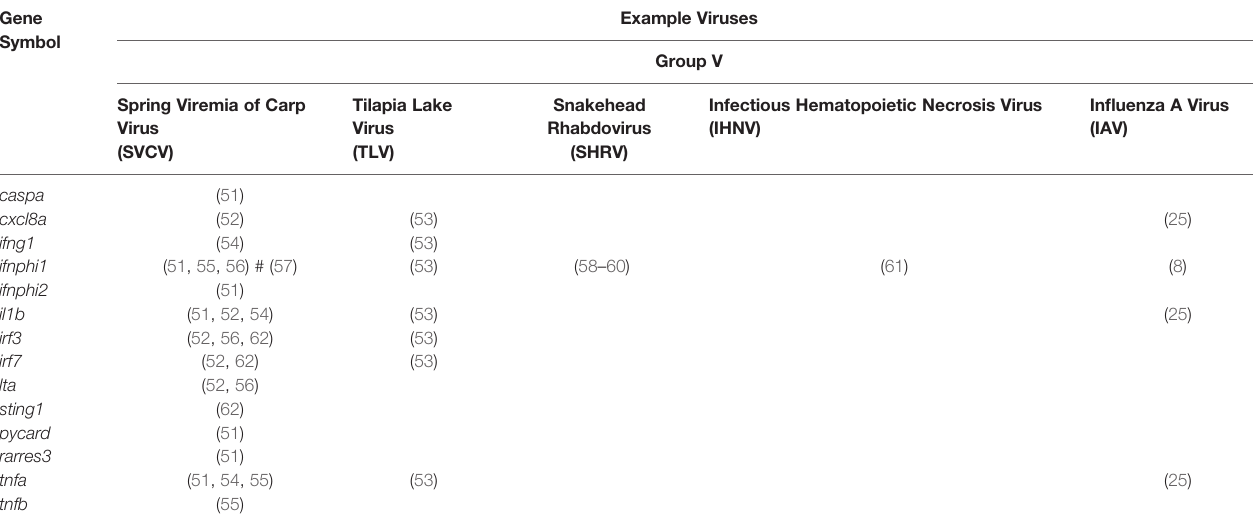
Example Viruses